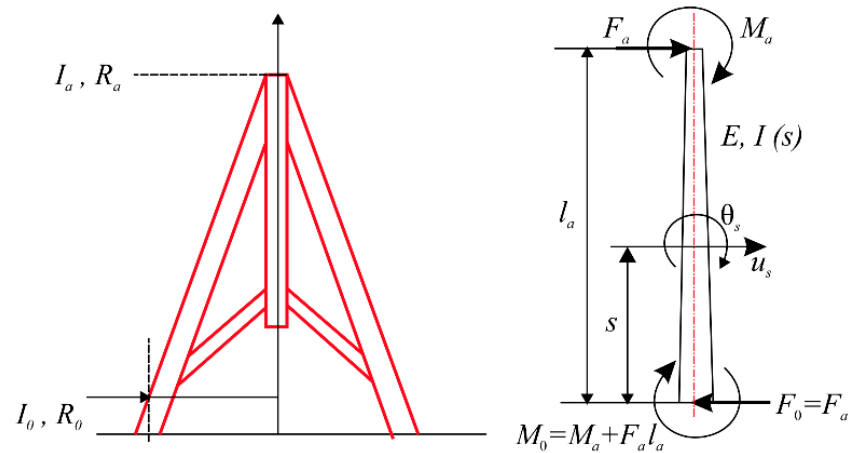
Figure 11. Simplified Euler beam model for tripod structure.